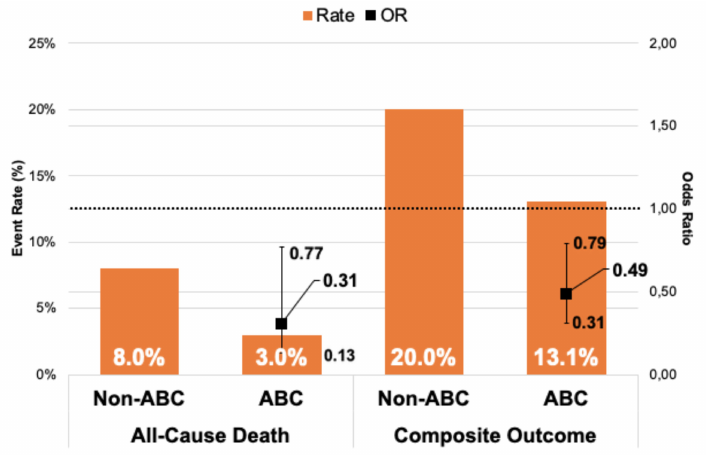
Figure 1. Relationship between events rates and odds ratio of clinical outcomes in 6 months follow-up. Legend: Whiskers represent 95% CI; CI = Confidence Interval; OR = Odds